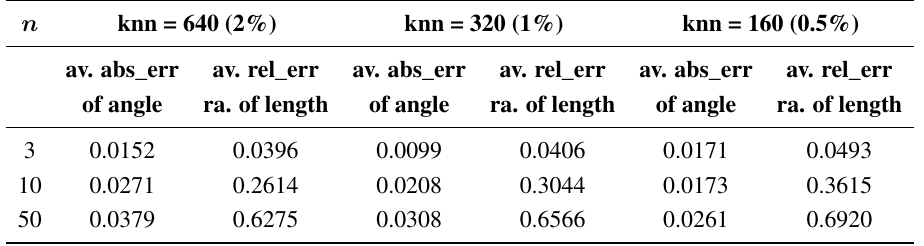
Table 8. The results of (cid:96) MCDA on four superimposed Gaussian distributions with 10% 1 artificial